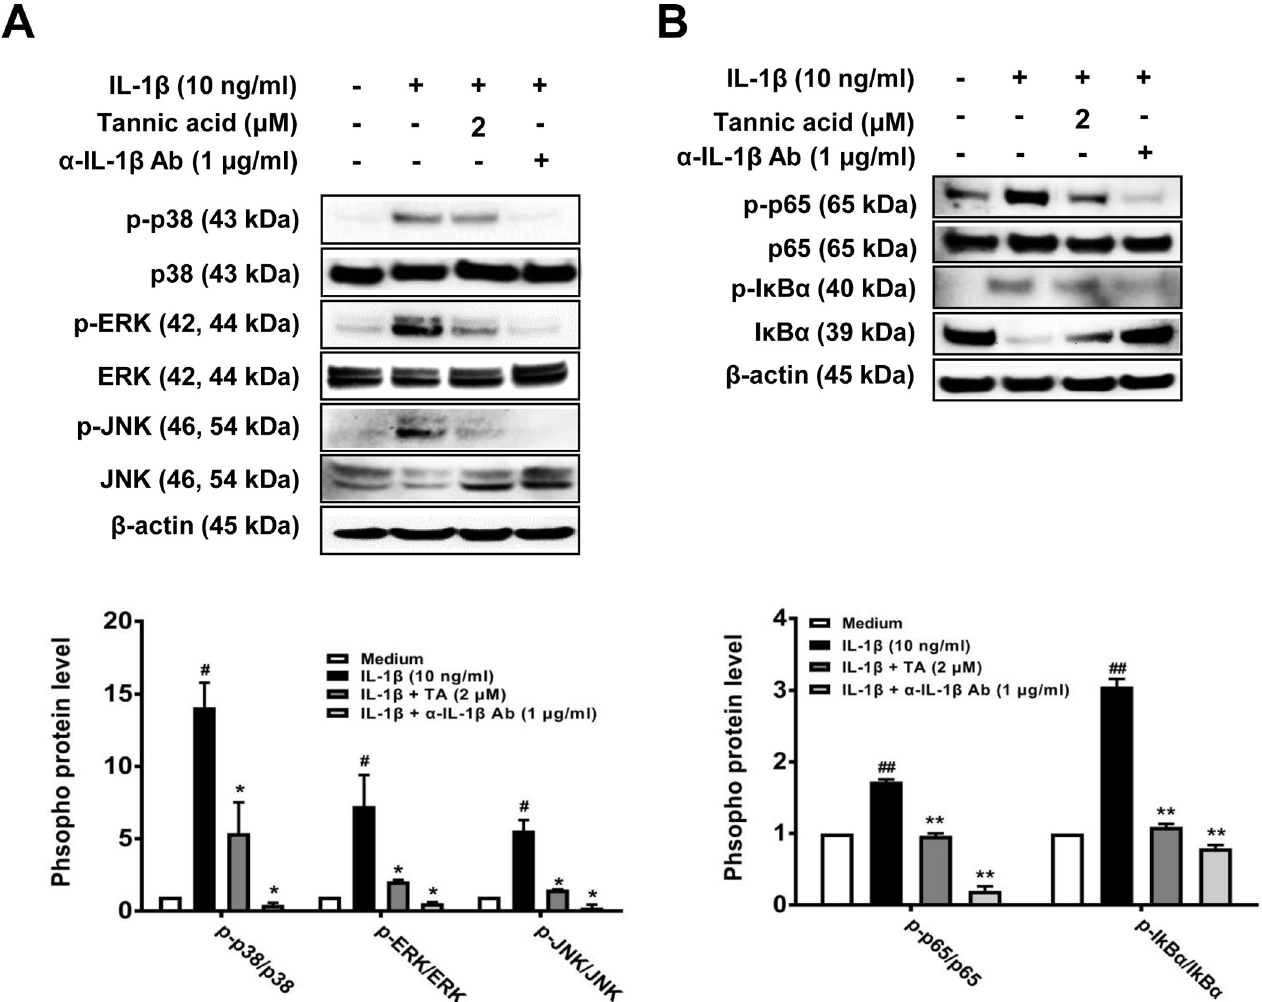
Fig 4. Effects of TA on IL-1 β -induced MAPK and NF- κ B activation in human OA chondrocytes. Human articular chondrocytes from OA patients were seeded onto 6-well plates (3 × 10 5 cells/well), and serum-starved cells were co-treated with various concentrations of TA (2 μ M), or anti-IL-1 neutralizing antibody (1 μ g/ml) and IL-1 β (10 ng/ml) for 1 h (A) or 3 h (B). Protein expressions of phosphorylated and non-phosphorylated forms of p38, ERK, JNK, p65, and I κ B α were detected by Western blot analysis. β -actin was used as a loading control. Band intensity was analyzed using Image J program. # p < 0.01 compared with medium only control group and * p < 0.01 compared with IL-1 β -treated group.